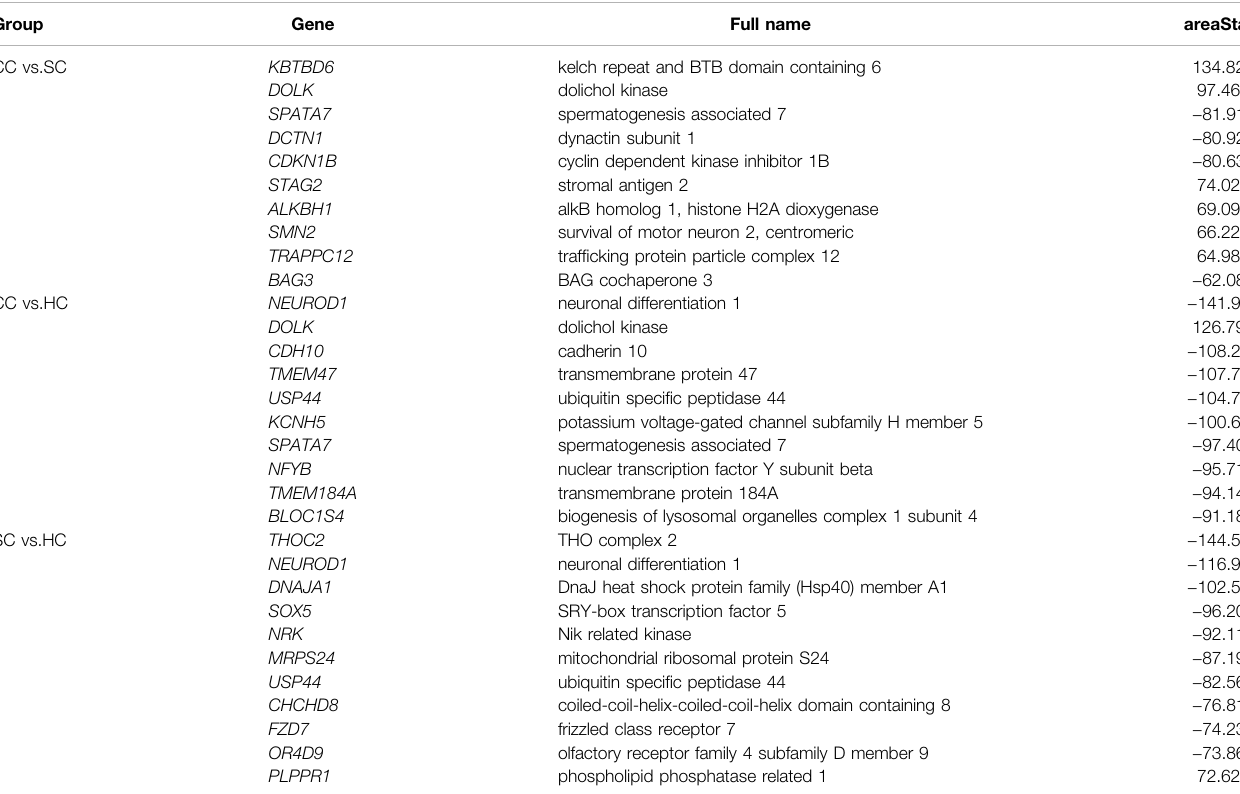
TABLE 3 | The top 10 DPMGs among clinical, subclinical, and healthy groups. Group